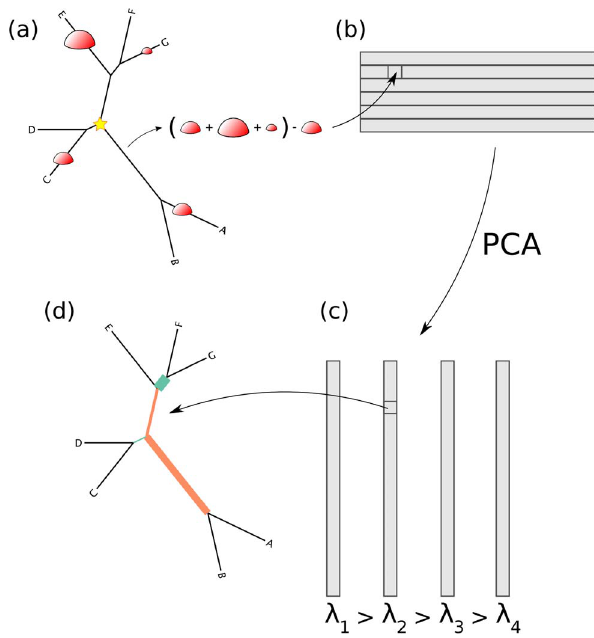
Figure 2. A visual depiction of the squash clustering algorithm. When two clusters are merged, their mass distributions are combined according to a weighted average. The edges of the reference tree in this figure are thickened in proportion to the mass distribution (for simplicity, just a subtree of the reference tree is shown here). In this example, the lower mass distribution is an equal-proportion average of the upper two mass distributions. Similarities between mass distribu- tions, such as the similarity seen between the two clusters for the G. vaginalis clade shown here, are what cause clusters to be merged. Such similarities between internal nodes can be visualized for the squash clustering algorithm; the software implementation produces such a visualization for every internal node of the clustering tree. Note that in this figure only the number of reads placed on each edge is shown, although each placement has an associated location on each edge when performing computation.